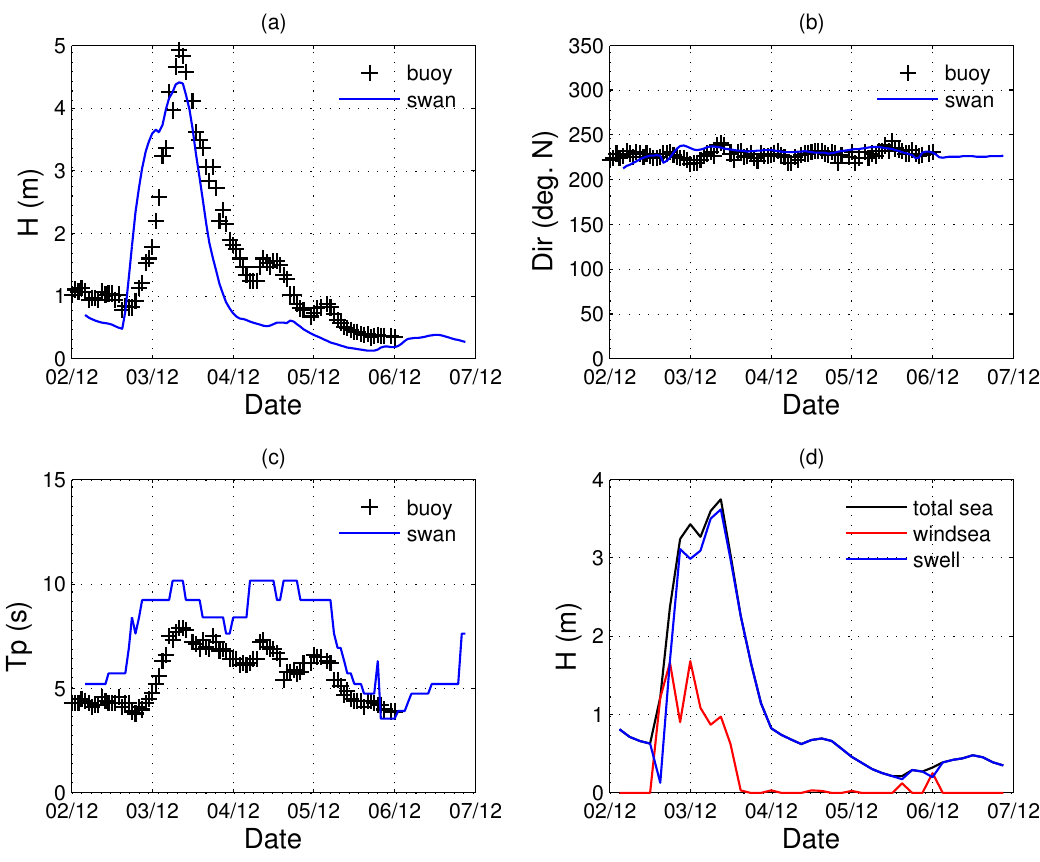
Fig. 6. Carrara, 2-7 December 2007 storm: (a) comparison of H s SWAN vs. buoy records (b) comparison of T p SWAN vs. buoy records (c) comparison of Dir SWAN vs. buoy records (d) WAM series of wind sea, swell and total H s out of the regional grid